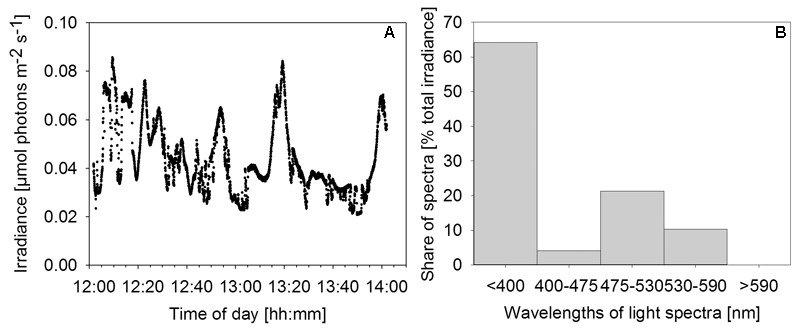
Irradiance and relative wavelength abundance in situ. (A) Time series of in situ irradiance (270°) available to the mat over 2 h starting at noon on December 1st, 2013. Weather: sunny with occasional clouds. (B) Percentage share of wavelength ranges in total downwelling light reaching the mat as determined by application of a series of longpass filters.